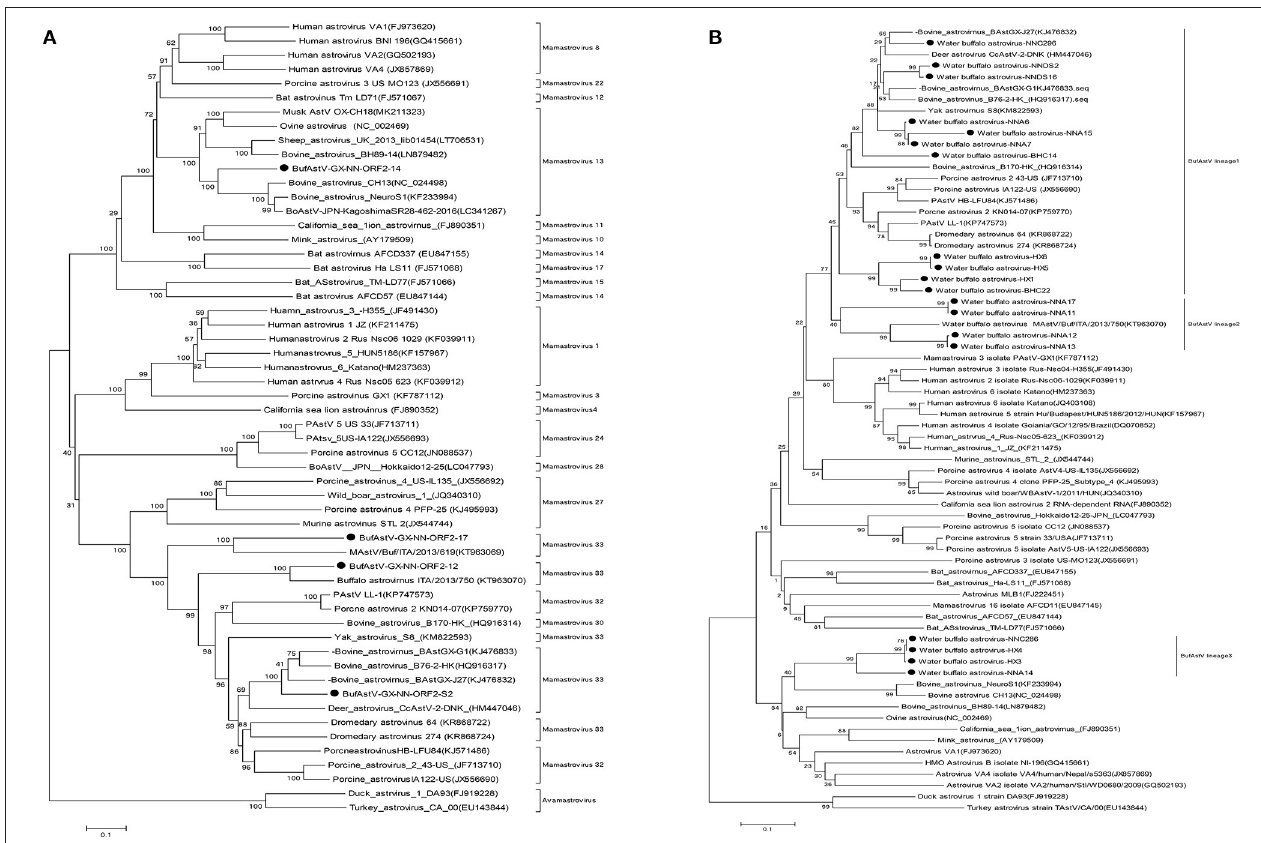
FIGURE 1 | The neighbor-joining phylogenetic trees of the full-length ORF2 (A) and partial ORF1b genes (B) of AstVs with p -distances for nucleotide sequences and 1,000 replicates were used for the bootstrap test. The black dots indicate the sequences from this